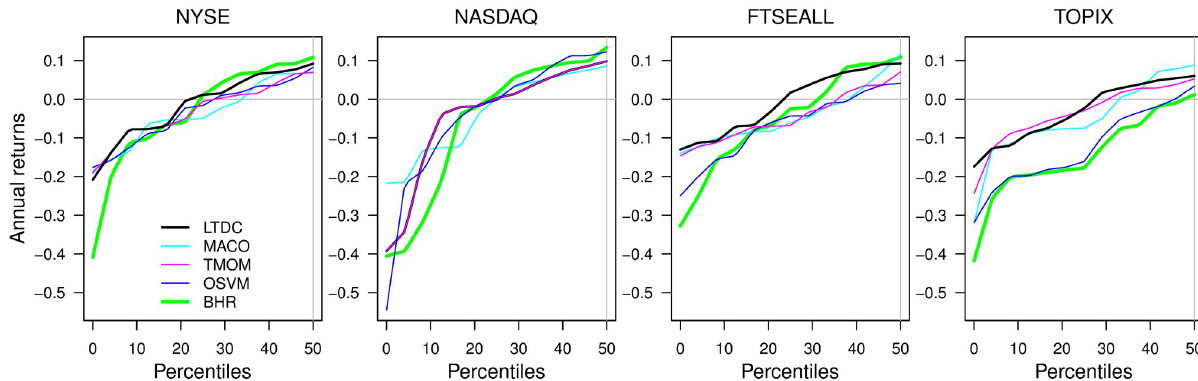
Fig 8. Quantile points of negative returns at the d